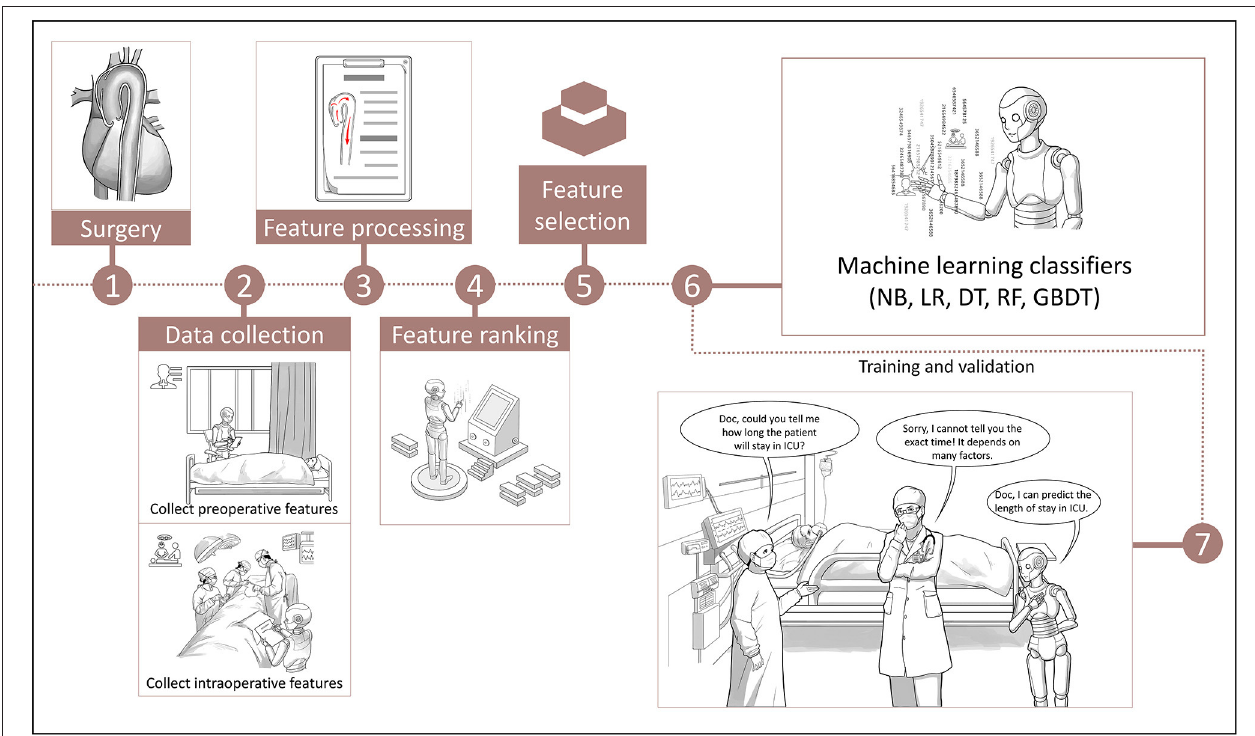
FIGURE 3 | The cartoon flow chart of machine learning models building. NB, Naive Bayes; LR, Linear Regression; DT, Decision Tree; RF, Random Forest; GBDT, Gradient Boosting Decision Tree; ICU, intensive care unit.